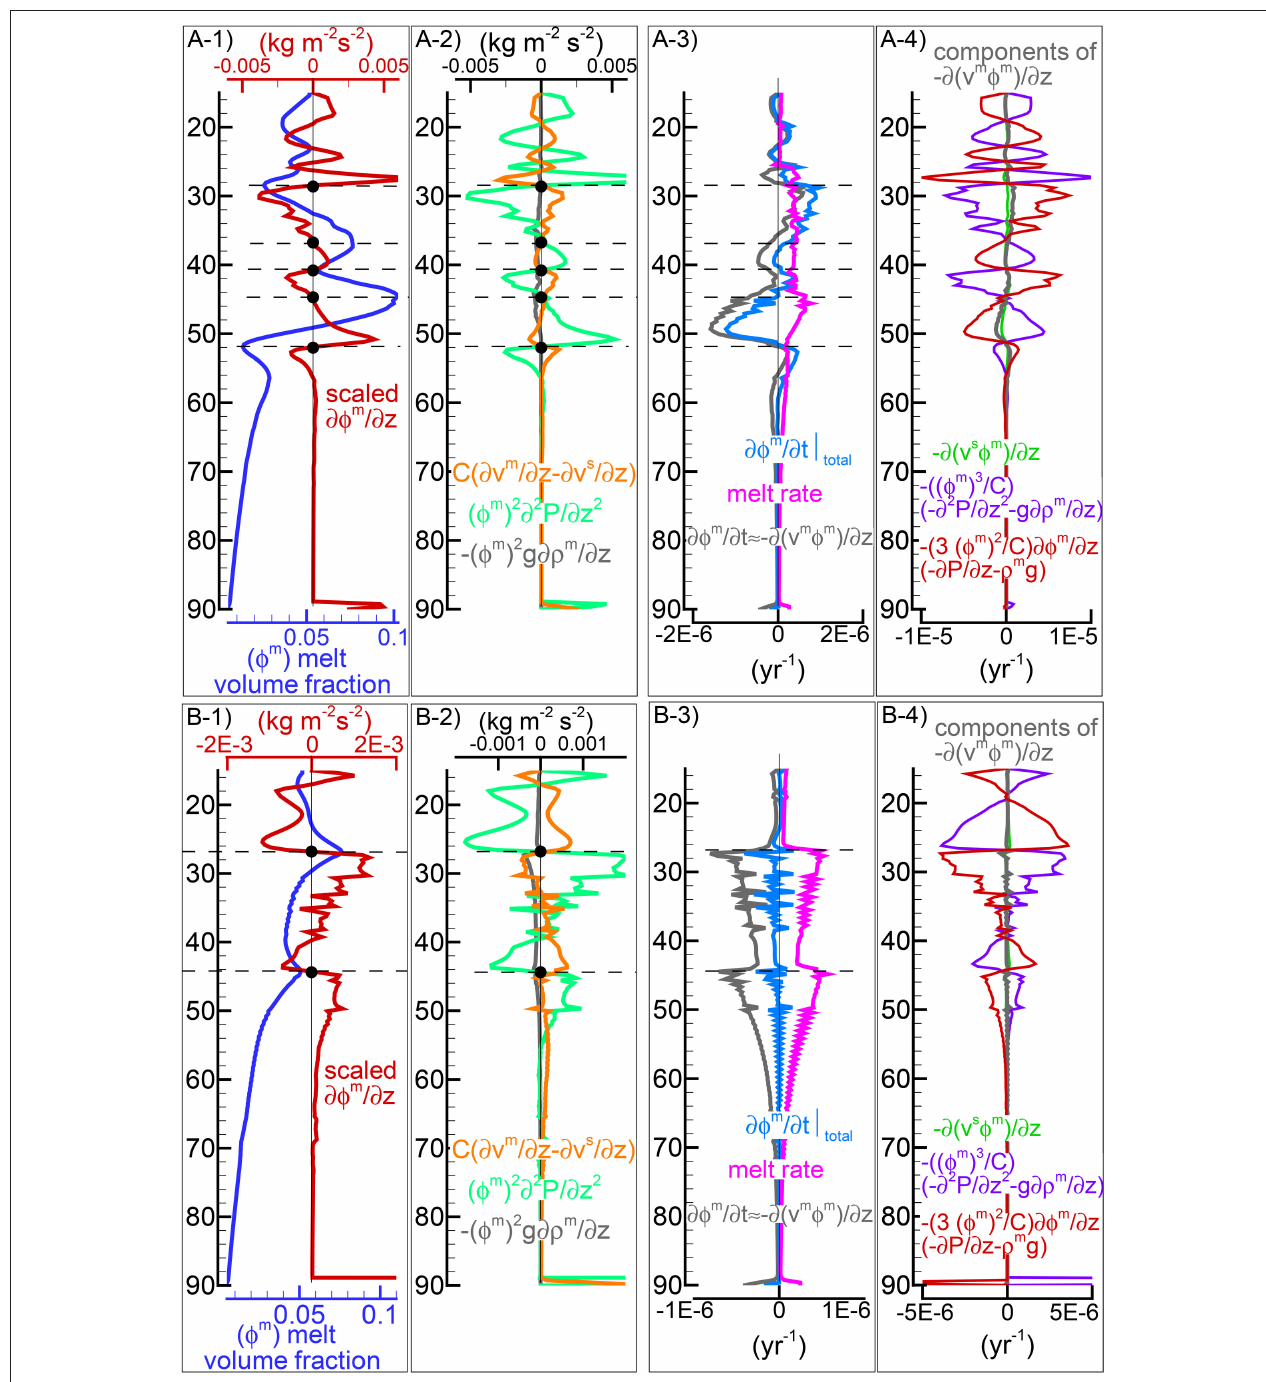
FIGURE 6 | Flow analysis of the simulations shown in Figures 4 , 5 . (A-1–A-4) Refer to the model with µ s = µ s 0 and µ s 0 = 1 e 21 Pa s. (A-1) Variation with depth of the melt fraction at 4.27 Myr and scaled ∂φ m /∂ z which characterizes the inversion point at ∂φ m /∂ z = 0. (A-2) The three components defining the scaled ∂φ m /∂ z . (A-3) Temporal variation of the melt fraction. The total variation ∂φ m /∂ t | total is the sum of − ∂ ( φ m v m ) /∂ z ≈ ∂φ m /∂ t and the melting rate retrieved from the thermodynamic and dynamic models (see section Thermodynamic Computation). (A-4) Components forming − ∂ ( v m φ m /∂ z . See section “Results from the Dynamic Equilibrium Melting Model” for a discussion of these quantities. (B-1–B-4) same as (A-1–A-4) but for the model with µ s = µ s 0 (1 + 1 /φ m ) and µ s 0 = 1 e 20 Pa s that is shown in Figure 5 at 3.2 Myr.